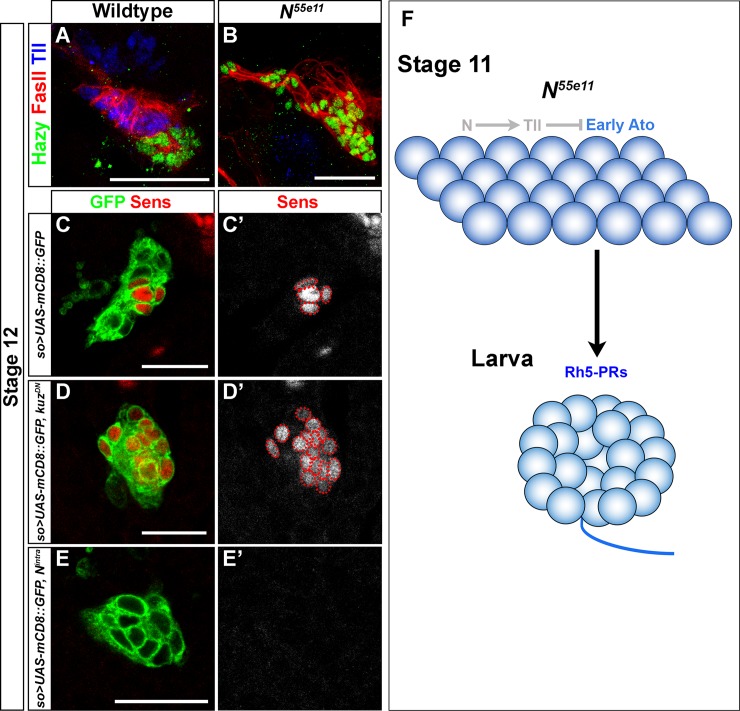
Notch represses sens-mediated binary cell fate decision and controls primary versus secondary PR precursor cell fate.(A, B) Tll (blue) expression analysis in the optic placode in wildtype and N55e11 mutant stage 12 embryos. Hazy (green) marks all PR precursors and FasII (red) labels larval eye and optic lobe primordium at this stage. Tll is expressed in the optic lobe primordium but not in the PR precursors in wildtype (A). In N55e11 mutant embryos Tll expression is completely absent (B). (C, C’ D, D’, E, E’) Sens (red) expression in wildtype and in embryos overexpressing a dominant negative form of Kuzbanian (KuzDN) or the intracellular domain of Notch (Nintra) in the optic placode by using a so-Gal4, UAS-mCD8::GFP recombinant transgenic line. Sens is normally expressed in four PR precursors in wildtype (C’), which adopt the primary PR precursor cell fate. Overexpression of KuzDN in the optic placode leads to an increase in the number of Sens expressing cells (D’), whereas overexpressing Nintra results in loss of Sens expression from the presumptive primary PR precursors (E’); z-projections of confocal sections. (F) Schematic representation of Notch mediated neuroepithelial patterning and regulation of cell fates in the embryonic optic placode. Notch activity is required for tll expression, and thus, indirectly and negatively regulates ato expression. Notch also represses sens expression. In N55e11 mutant this repression is removed and ectopic Sens induces primary PR precursor cell fate while repressing secondary PR precursor cell fate. Scale bars represent 20 μm.